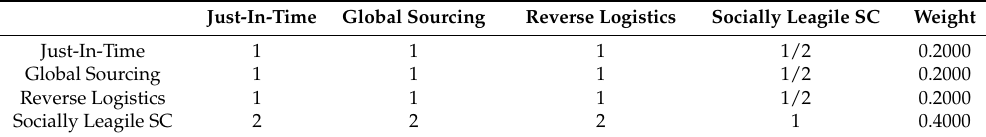
Table A13. Pairwise Comparison of Alternative w.r.t. sub-criterion Labor Equity.